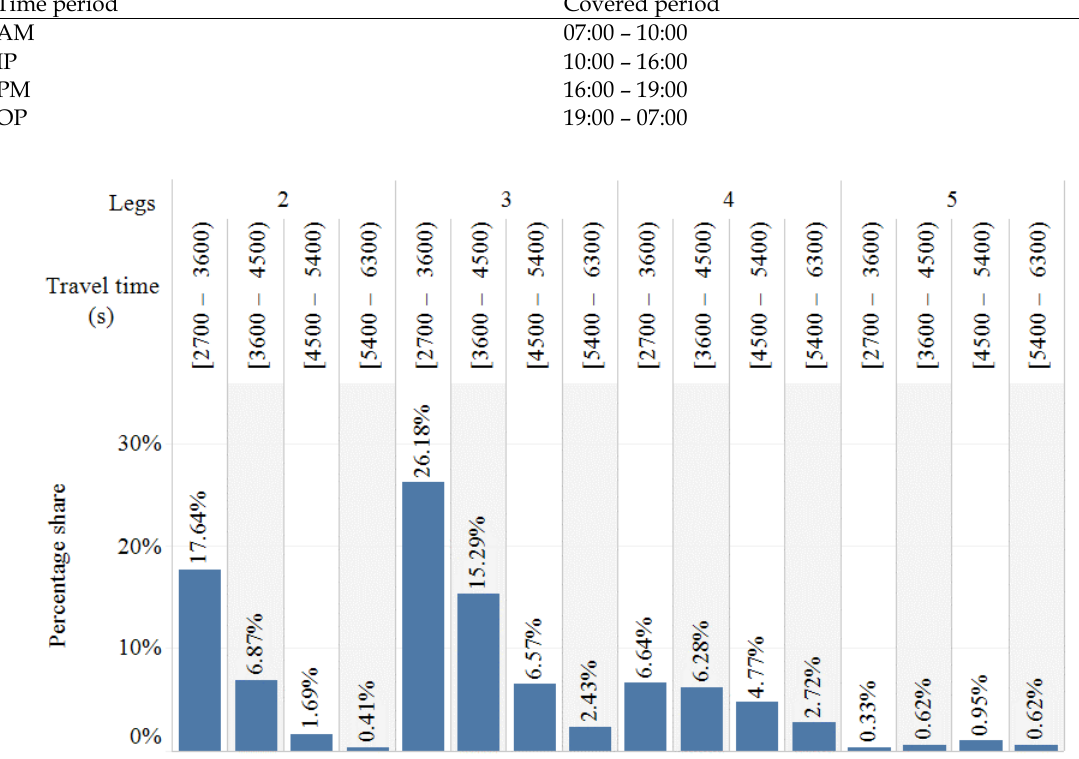
The applied joint distribution for the synthesis of tours by number of legs and total travel